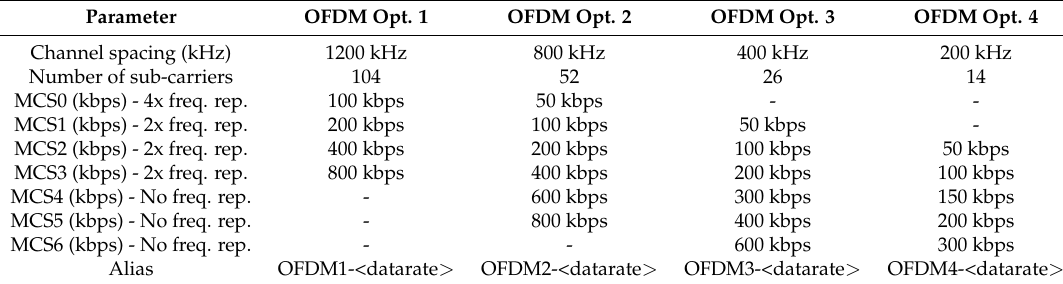
Table 2. Radio settings using OFDM modulation. The values of these parameters are defined in the standard [22]. Channel spacing is the separation between the centers of two adjacent channels. OFDM channels group a number of sub-carriers, option 1 being the widest one (the most number of sub-carriers), option 4 the narrowest (the least number of sub-carriers). The data rate depends on the combination of the MCS (Modulation and Coding Scheme) value and the OFDM option. Frequency repetition identifies the number of sub-carriers encoding the same information. The “Alias” of each radio setting is used to identify each set of parameter, e.g., OFDM1-400 identifies the PHY using OFDM option 1 and